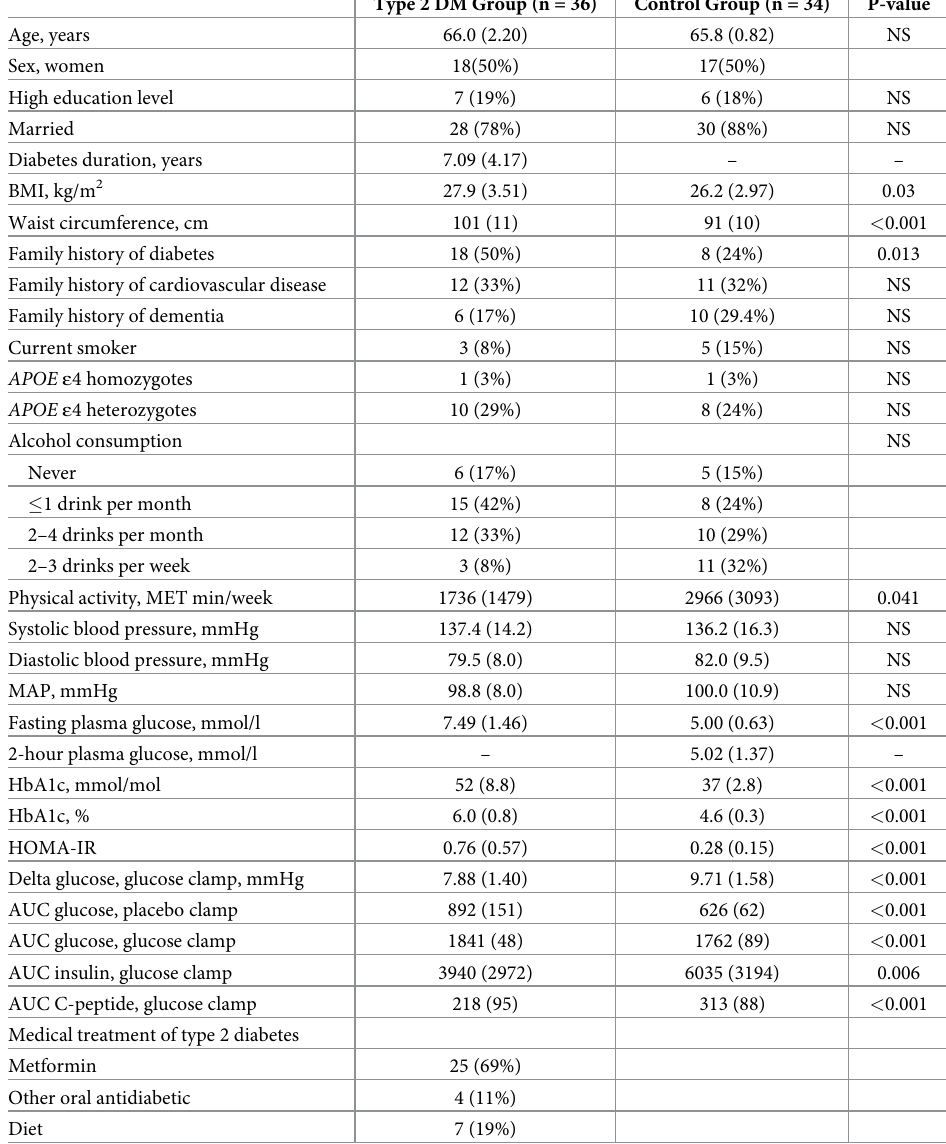
Table 1. Characteristics of the study